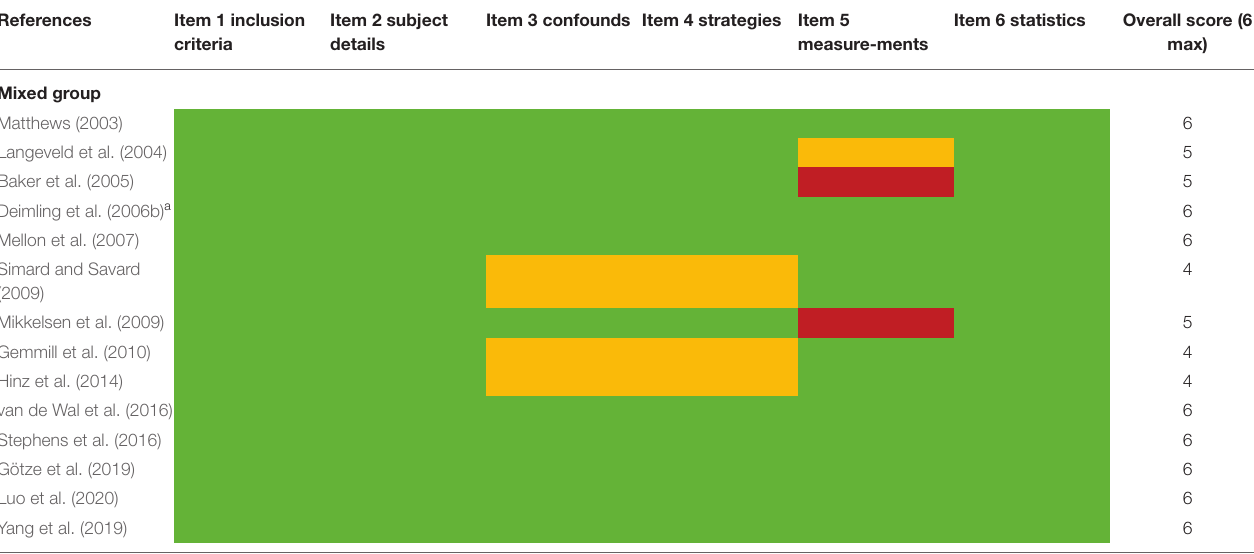
TABLE 2B | Quality assessment by modified Joanna Briggs tool on the included studies in mixed